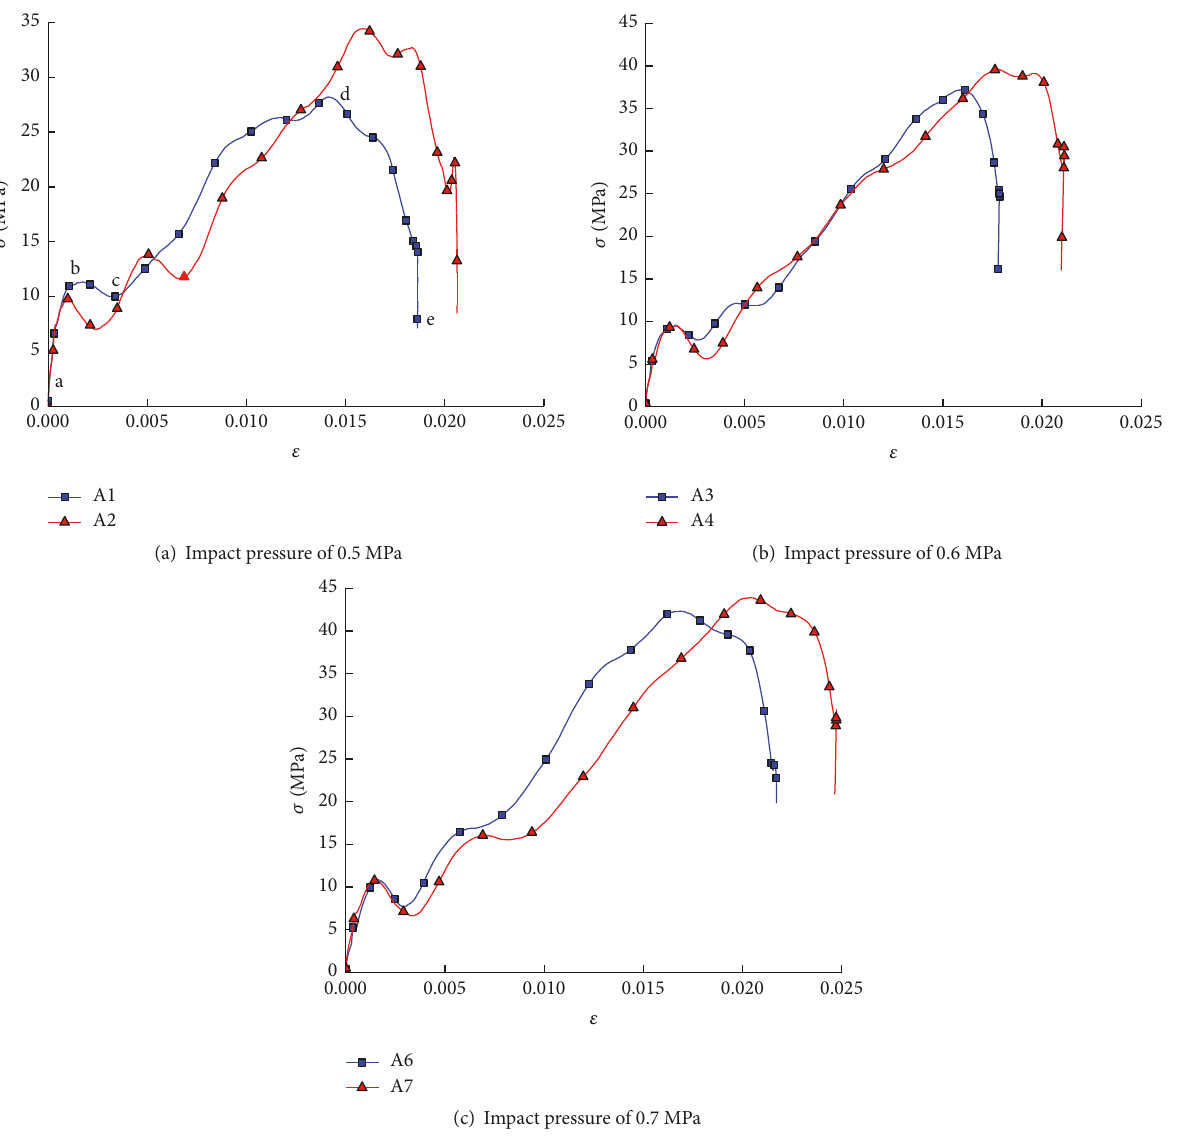
Figure 7: Stress-strain curves of coal-rock combined body